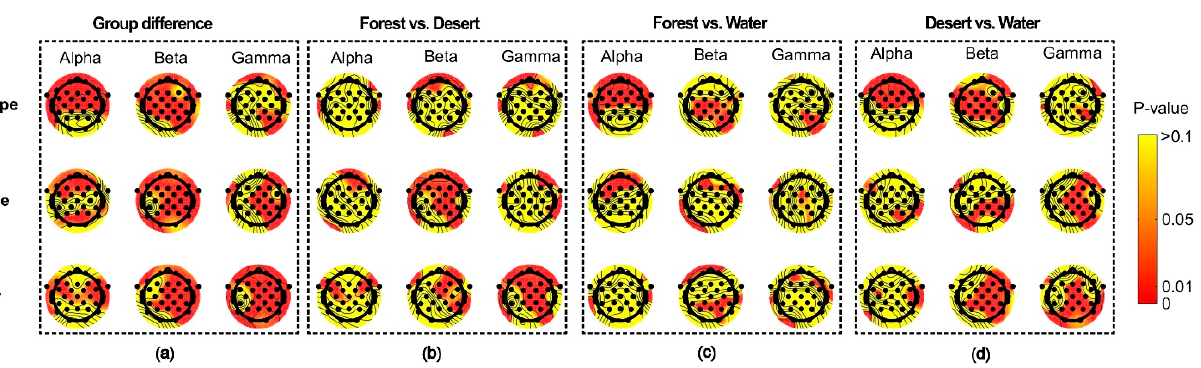
Figure 7. The difference in distribution of brain waves for alpha and beta waves among landscapes in different scenarios. ( a ) the group differences among different scenarios, ( b ) the difference between forest and desert, ( c ) the difference between forest and water, ( d ) the difference between desert and water.